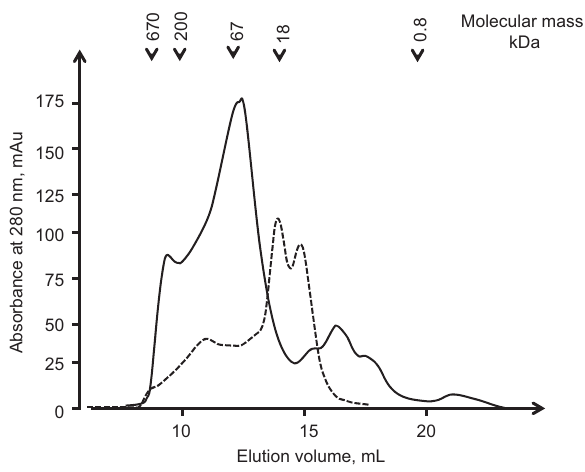
Figure 4 Gel-filtration chromatogram of active site 2 (full line) and active site 3 (dashed line) at pH 12.0 and 1 M urea. Elution volume of molecular mass markers is shown on top of the chromatogram. The main peak of active site 2 (full line, calculated monomeric mass 17 kDa) elutes at roughly trimeric size of approximately 51 kDa. Active site 3 (dashed lined, calculated molecular mass of 8.5 kDa) elutes with a double peak approximately at the size of the dimer (17 kDa) and the monomer (8.5 kDa).